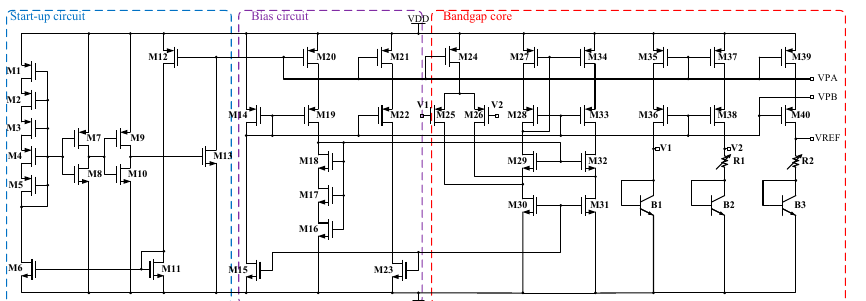
Figure 8. Bandgap schematic.